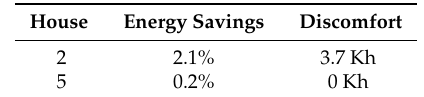
Table 12. Results for Case